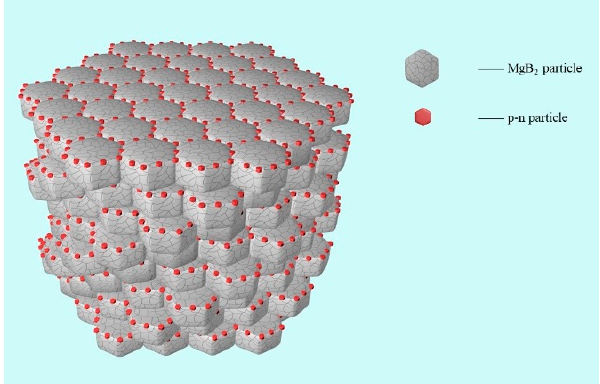
Figure 1. MgB 2 SMSCs model